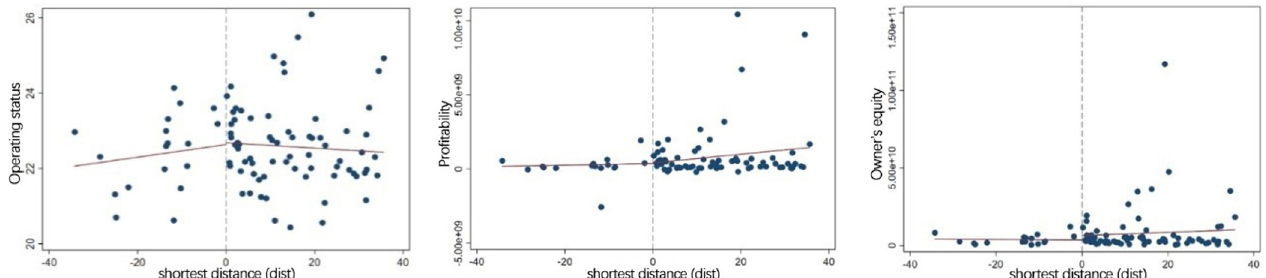
Fig 4. Changes of covariates at the cutoff. a (Operating status). b (Profitability). c (Owner’s equity).